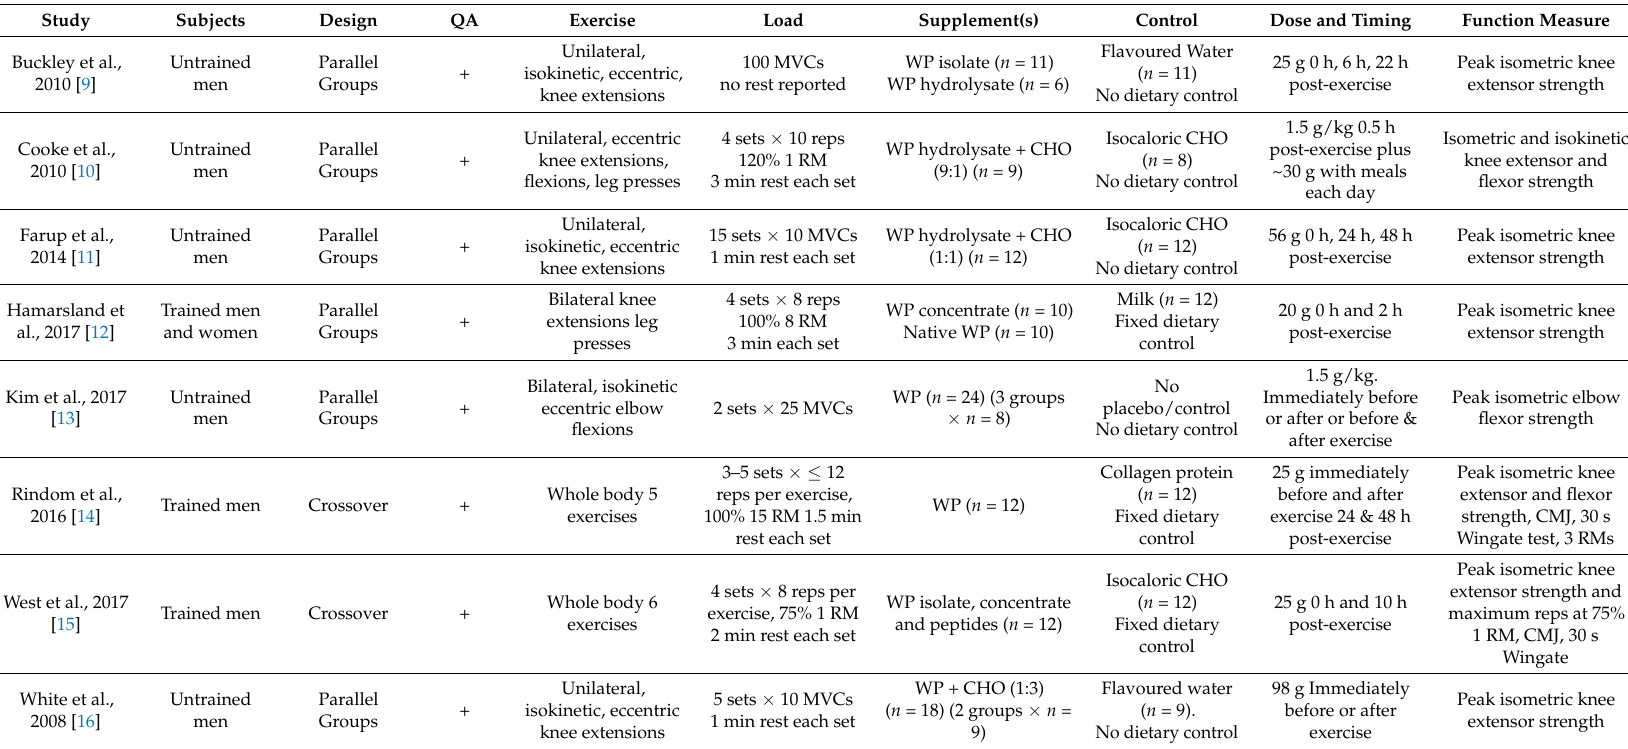
Table 1. Studies included in the systematic review and